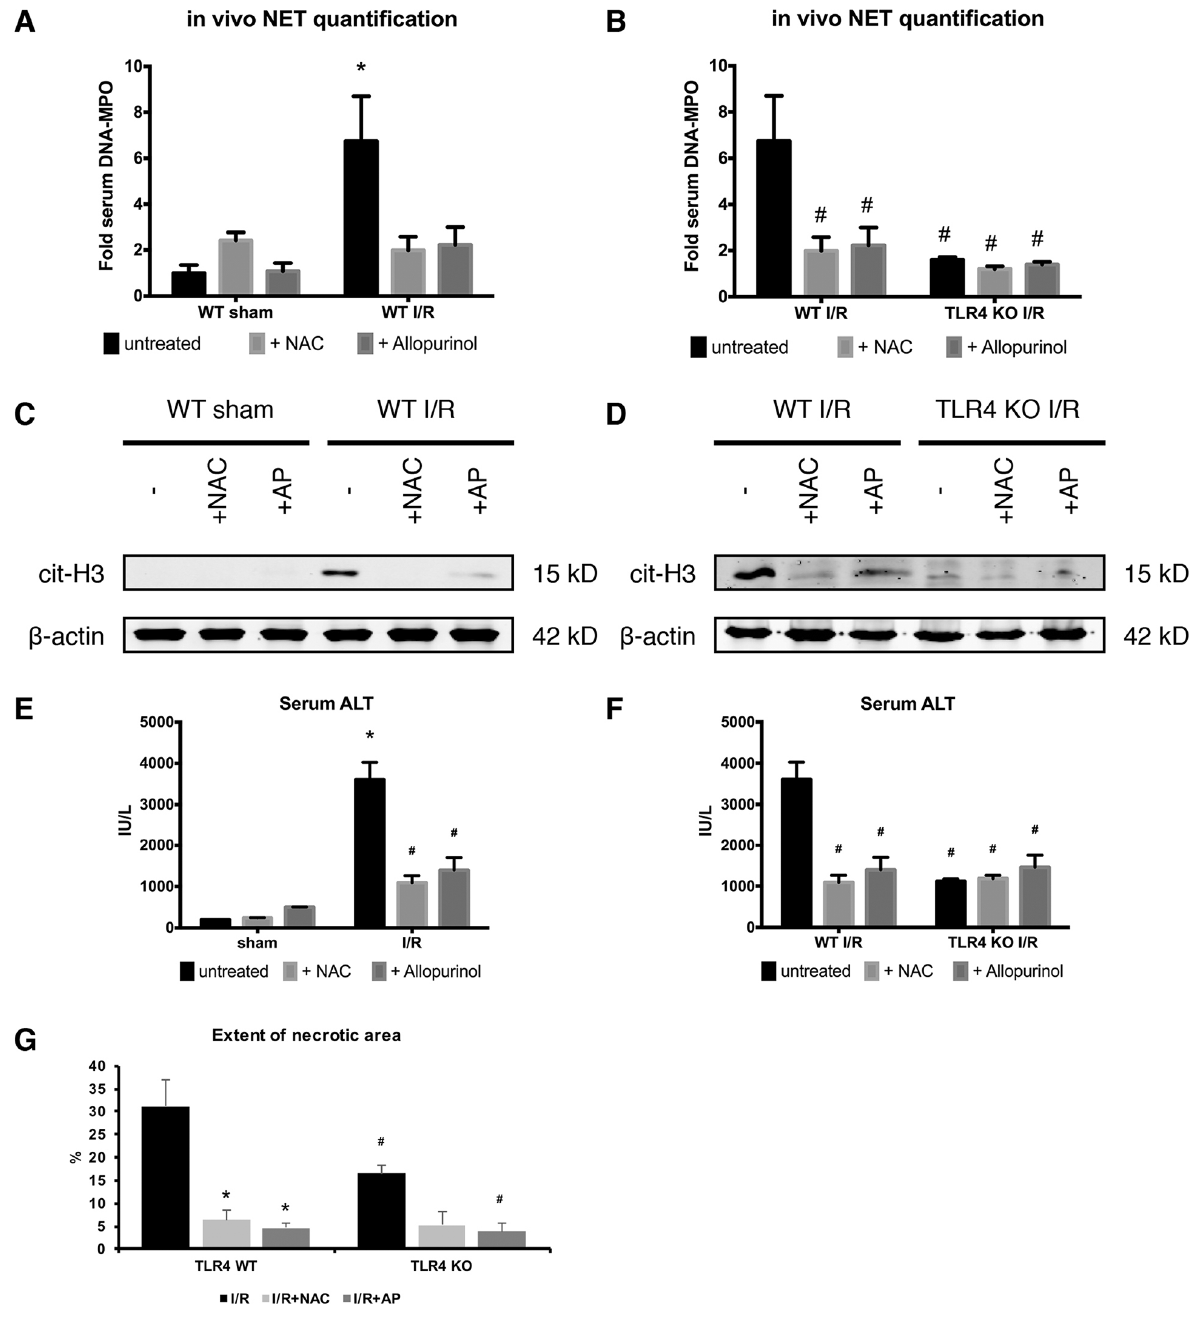
figure 4. Superoxide- and ROS-inhibitors reduce NETs in vivo. WT and TLR-4 KO mice underwent either sham laparotomy or 1 h of isch- emia and 6 h of reperfusion, and received control, N-acetyl-cysteine (NAC; 150 mg/kg) or allopurinol (50 mg/kg) treatment. (A) ELISA assay of circulating in vivo NET MPO-DNA complexes present in the serum of WT mice, or (B) TLR-4 KO mice after I/R and treatment as above. Shown as mean fold over control. * p < .05 vs respective uninhibited treatment. (C) Western blot of in vivo citrullinated Histone H3 levels after sham or I/R and treatment as above from WT liver protein lysates, or (D) WT and TLR-4 KO after I/R and treatment as above. β -actin is shown as a loading control. (E) Assay of serum ALT levels in WT mice, or (F) TLR-4 KO mice after I/R and treatment as above. Data represent the mean ± SEM (n = 6 or more mice per group). * p < 0.05 vs sham. # p < .05 vs untreated WT I/R group. (G) Quantifica- tion of necrotic hepatocytes in H&E stained liver sections from control-, NAC- or allopurinol-treated mice 6 h after reperfusion. * p < 0.05 vs WT control group after liver I/R; # p < .05 vs respective WT inhibitor–treated group after liver